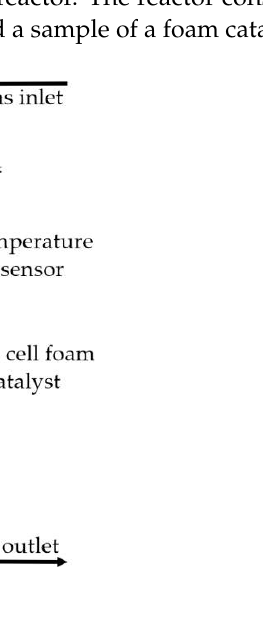
Figure 1. Experimental setup: ( a ) Reactor scheme. ( b ) Catalyst sample. The gas temperature range was 30–60 °С at a pressure of 1 atm. The mass fraction of corresponded to argon (24%), ethylene (74.93%), hydrogen (0.07%), and acetylene (1%). Passing through the catalyst, acetylene was hydrogenated to ethylene.